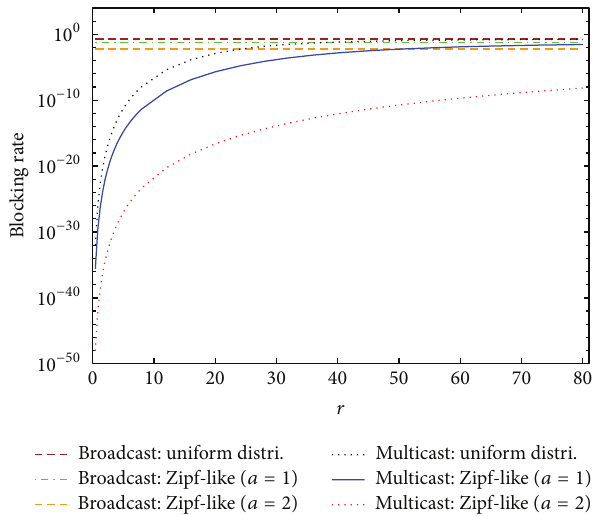
Figure 6: Blocking rates of broadcast and multicast IPTV services under different hit rate distributions.